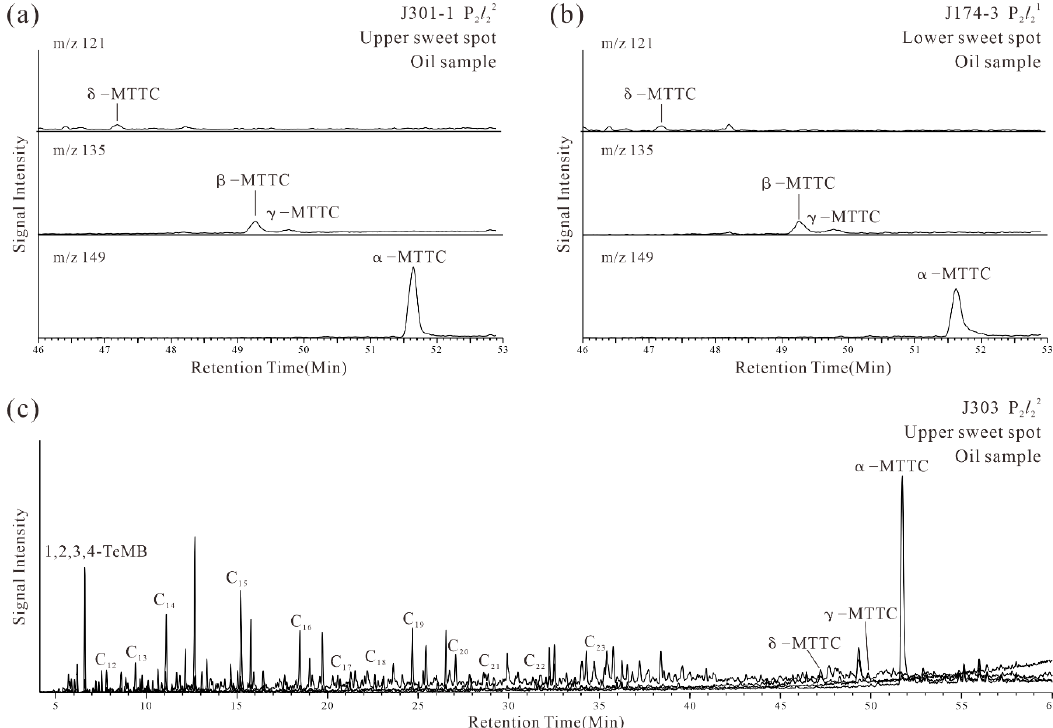
Figure 8. ( a , b ) Representative mass chromatograms (m/z = 121, 135, and 149) showing the 2-methyl- ( a , b ) Representative mass chromatograms (m / z = 121, 135, and 149) showing 4,8,12-trimethytridecyl chroman (MTTC) distribution of upper and lower sweet spot oil samples; and ( c ) combined mass chromatograms of m/z 120 + 121 + 133 + 134 showing MTTC and aryl isoprenoid distributions for crude oils from Jimsar sag.